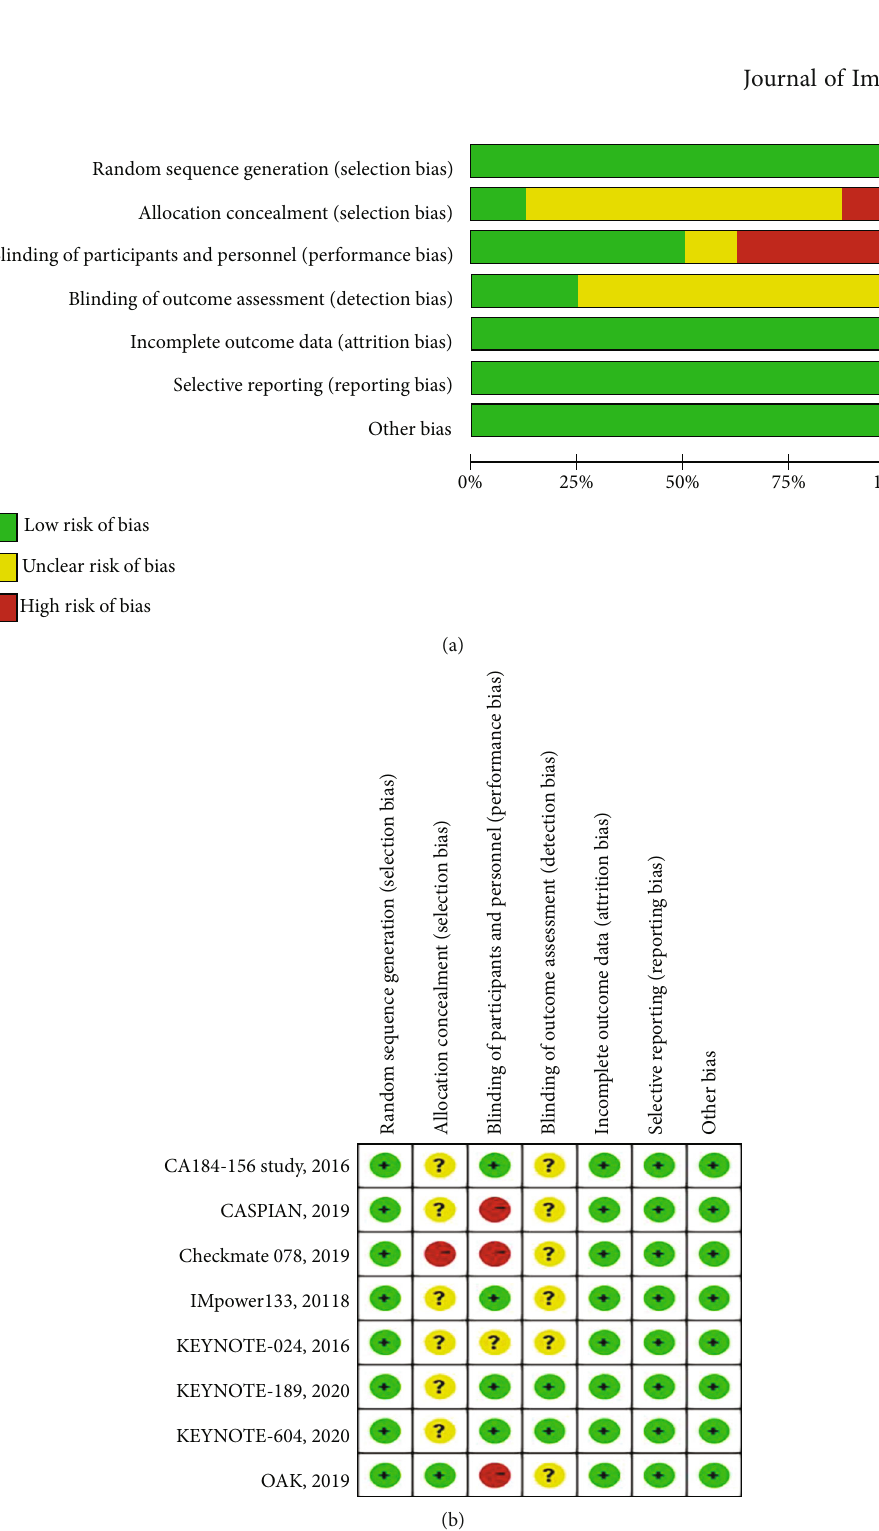
Figure 2: Assessment of risk of bias. (a) Methodological quality graph: authors ’ judgment about each methodological quality item presented as percentages across all included studies. (b) Methodological quality summary: authors ’ judgment about each methodological quality item for each included study, “ + ” low risk of bias; “ ? ” unclear risk of bias; “ - ” high risk of